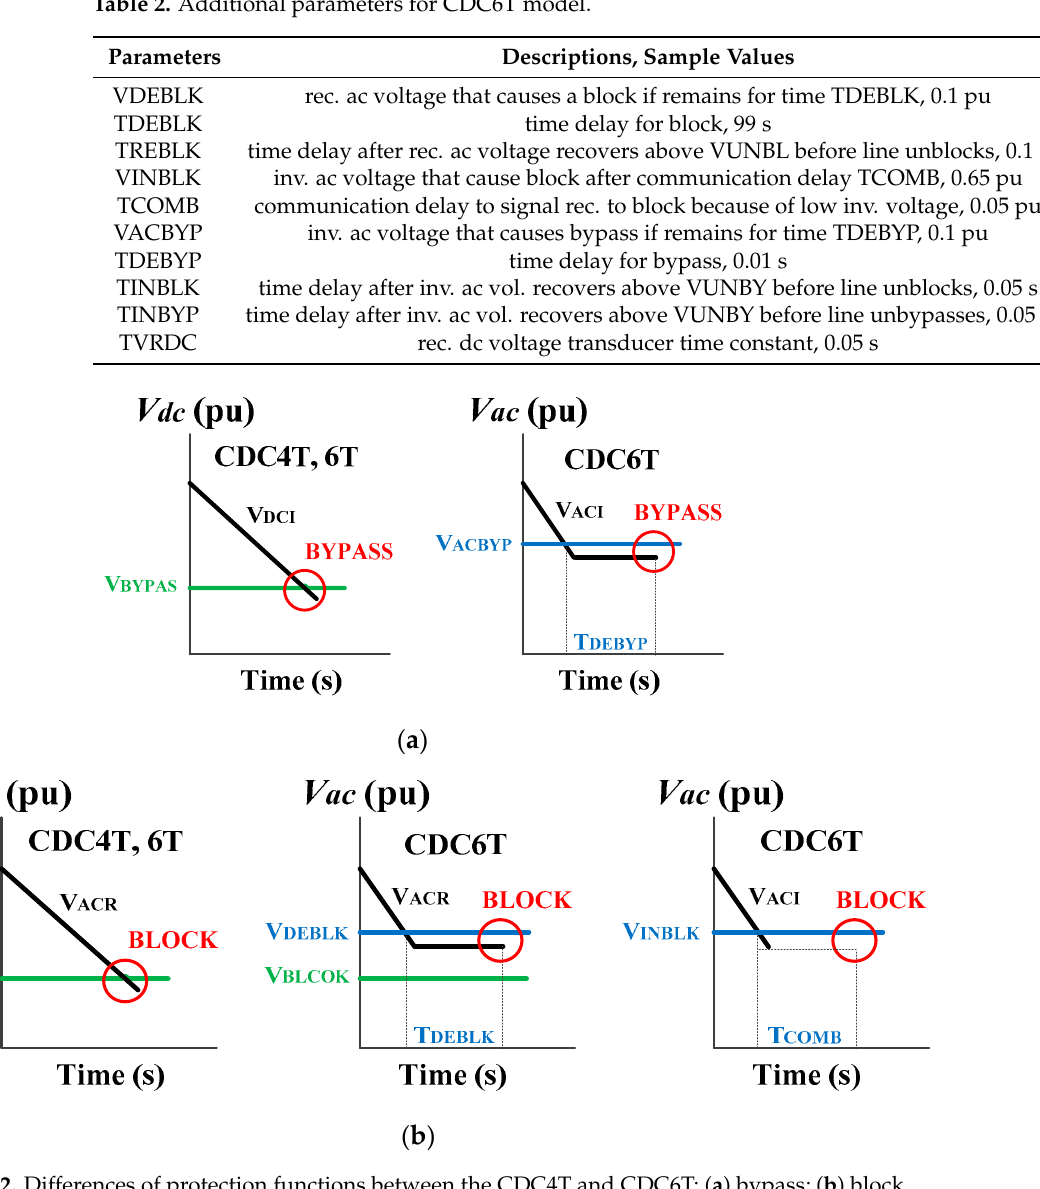
Table 2. Additional parameters for CDC6T model. Parameters Descriptions, Sample Values